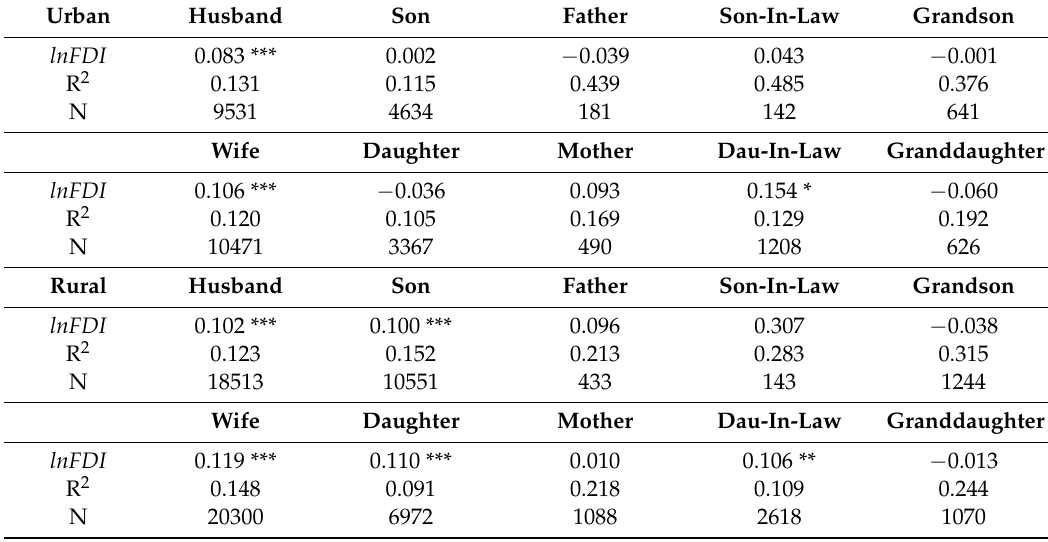
Table A1. Regression results of urban roles with age dummies (dependent variable: ln individual calorie).